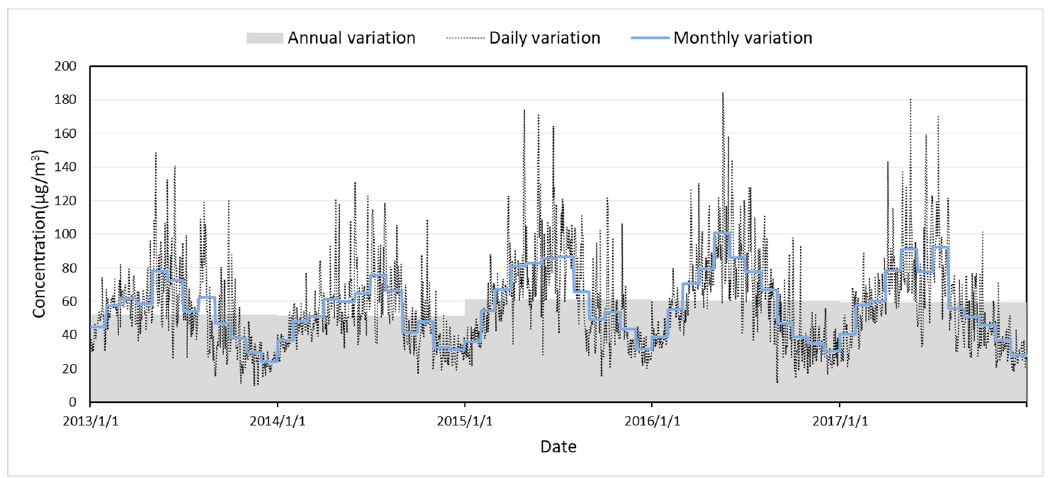
Figure 4. Variation of daily, monthly, and annual average O 3 concentrations in Changchun from 2013 to 2017.